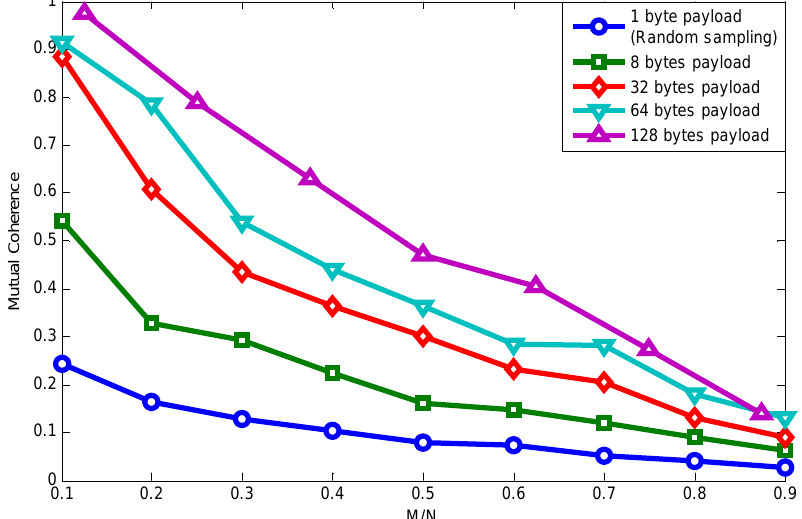
Figure 6. Packet length effect on relationship between M random compressive sensing (RCS)